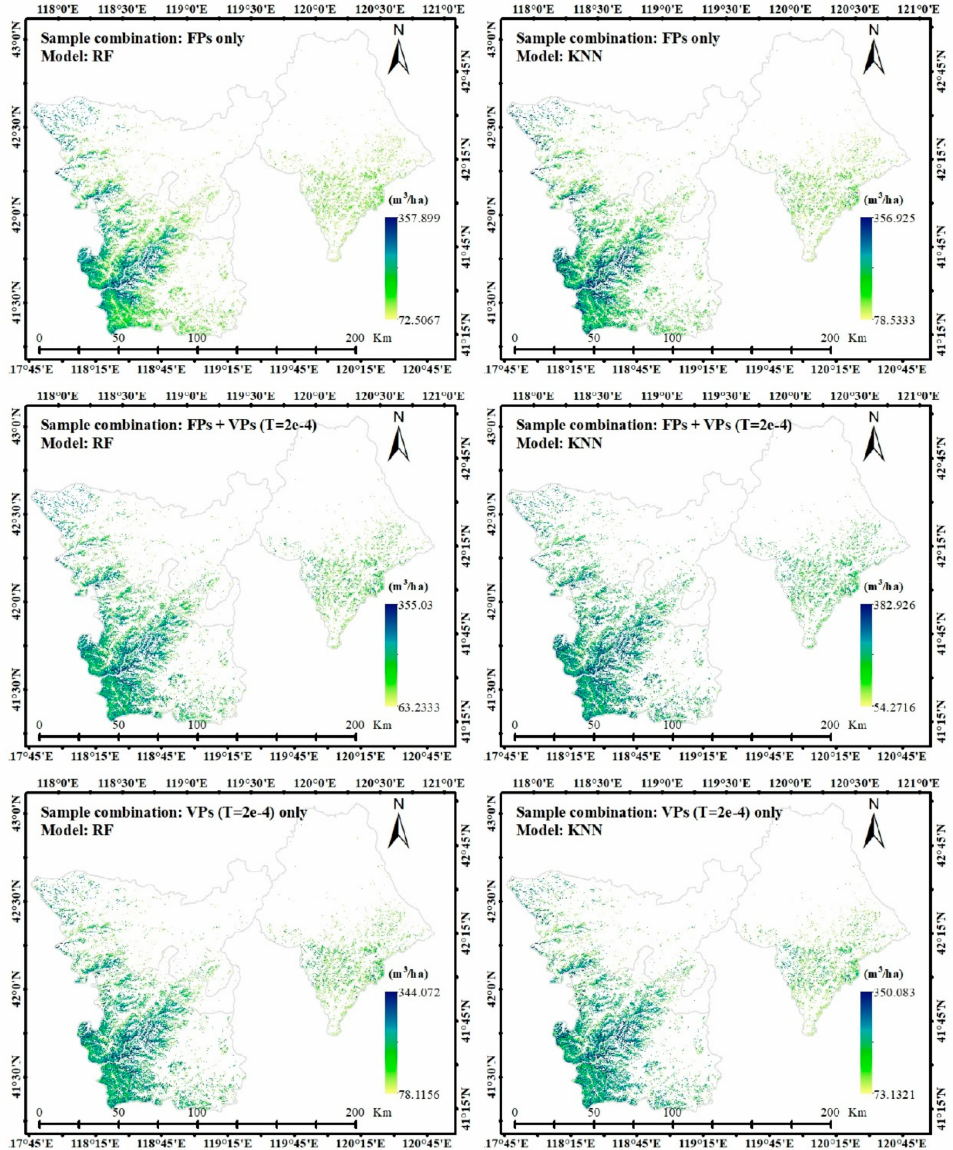
Figure 8. The spatial distributions map of forest volume separately using Random Forest and K-Nearest Neighbor algorithm under di ff erent plots combination at a given threshold value T = 2 × 10 − 4